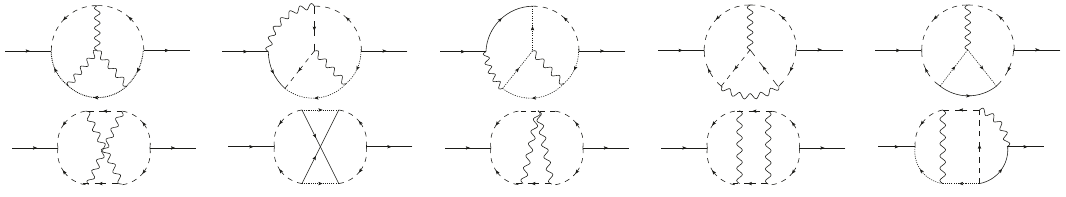
Figure 3 . Diagrams contributing at g 4 order in = 1 superspace formalism. The dashed and N dotted lines stand for the = 1 chiral (cid:12)elds Q; ~ Q belonging to the = 2 hypermultiplet, the N N wavy line stand for the = 1 vector multiplet, the straight line for the adjoint chiral multiplet. N